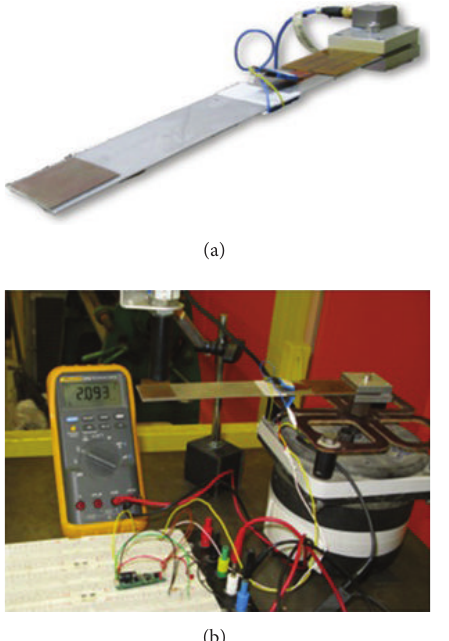
Figure 16: (a) Piezoelectric energy harvester (b) experimental setup [43].